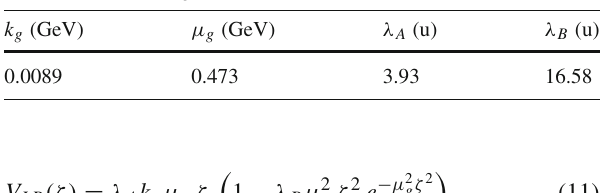
Table 1 Values of the parameters for V IR of Eq. (11). μ g , λ A , λ B are from Ref. [40]. For k g see Eq. (12) and